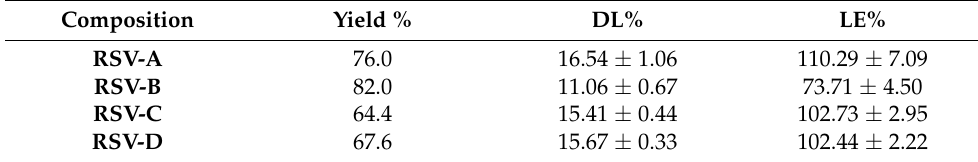
Table 4. Characterization of the spray-dried powders in terms of yield %, DL% and LE% ± SE ( n = 3). Composition Yield % DL% LE% RSV-A 76.0